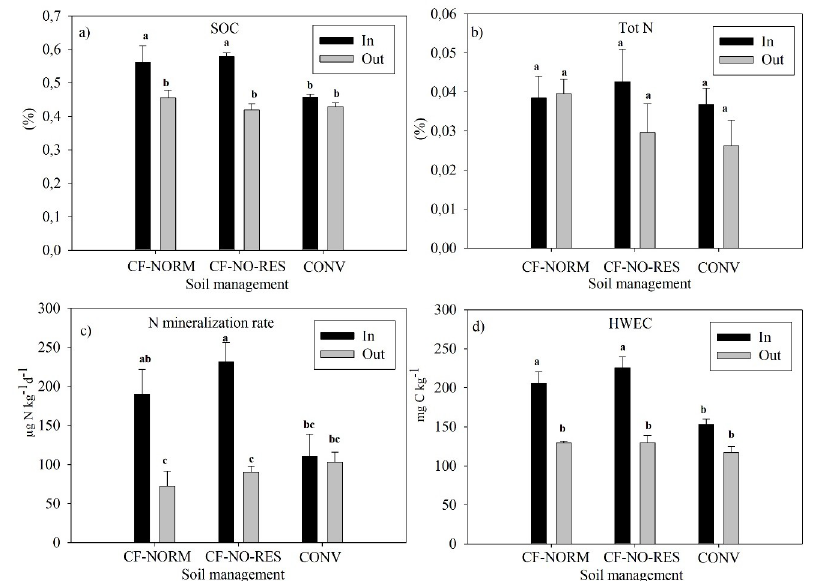
Fig 1. (a) Soil organic C, (b) total N, (c) N mineralization rate and (d) HWEC inside and outside basins under CF-NORM and CF-NO-RES and inside and outside planting rows in CONV in 2018 at 0 to 20 cm depth. The vales are depth weighted averages of the values from 0 to 8 cm and 8 to 20 cm. Error bars represent standard errors (n = 4). Lower case letters indicate significant differences (p < 0.05) between soil management practices inside and outside basins (or inside and outside rows of plants under